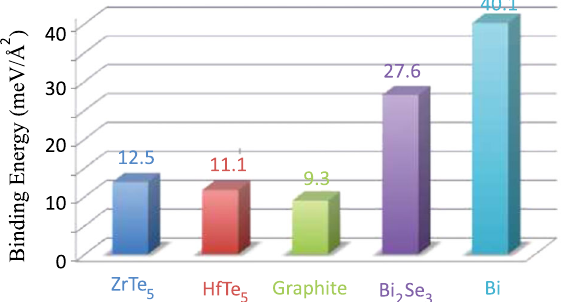
FIG. 2 (color online). The calculated interlayer binding ener- gies for several typical layered